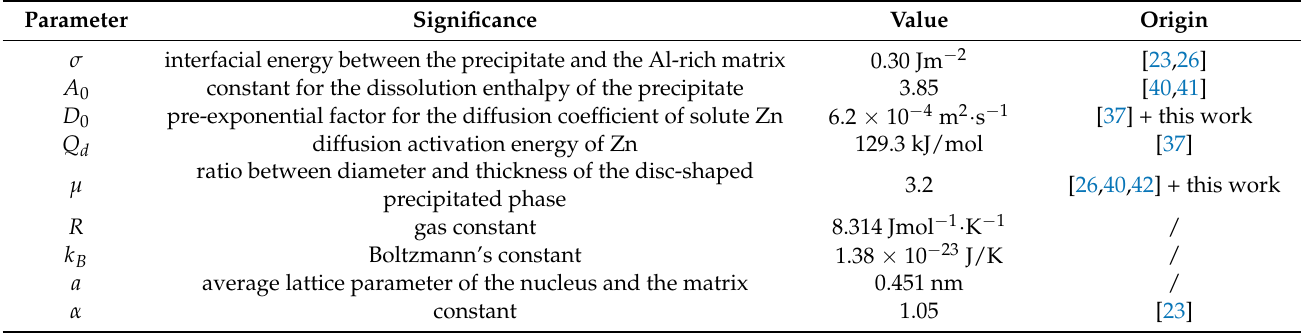
Table 3. Main parameters used in the model.